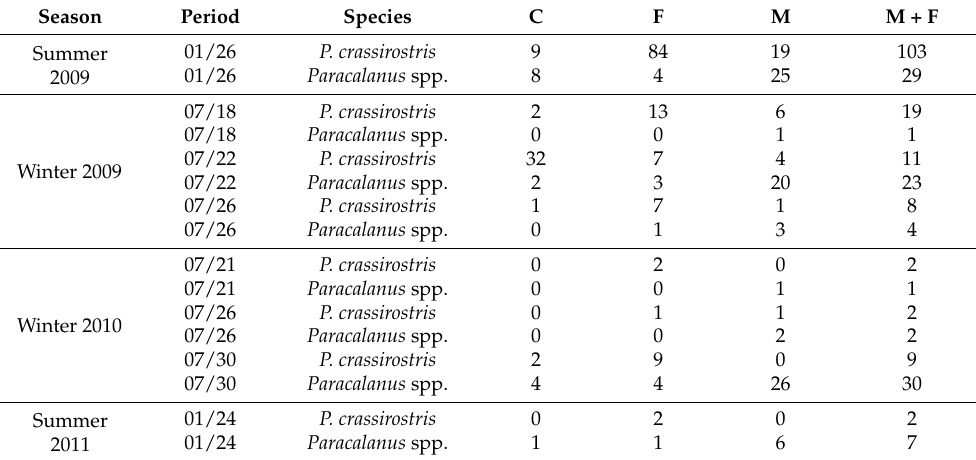
Table 2. Abundance estimates of infected Parvocalanus crassirostris and Paracalanus spp. (ind. m − 3 ) for each sampling occasion. C: juvenile copepodid, stages I to V; F: adult females; M: adult males; F + M: all